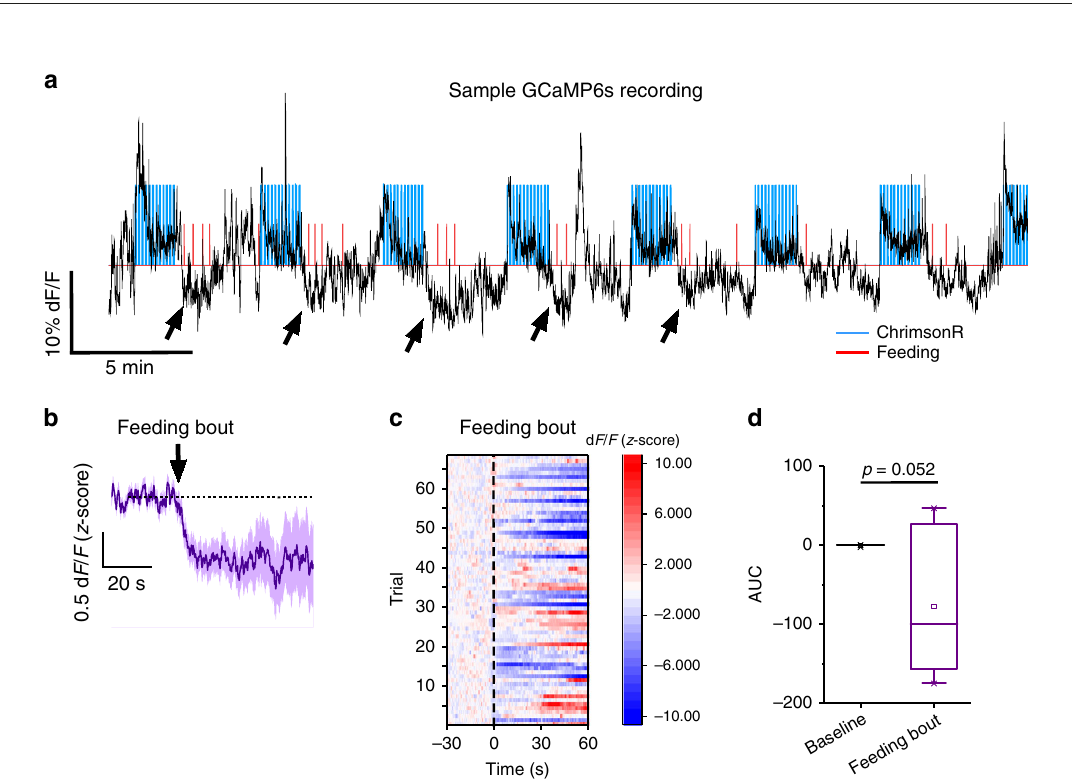
Fig. 4 The activity of pPVT – NAc neurons increases during food-seeking behavior in hungry mice and decreases during feeding. a Schematic of the viral vector strategy and optical fi ber placement used for selectively expressing GCaMP6s in NAc-projecting neurons of the pPVT. b Schematics of the reward foraging task. To initiate a trial, mice awaited in the trigger zone for an auditory cue (8 KHz, 1 s) which signaled reward availability. Mice then ran to the reward zone to retrieve a liquid food reward. c Heatmap of GCaMP6s responses from pPVT – NAc neurons during performance of individual trials of the foraging task. GCaMP6s responses were time-locked to cue onset and trials were sorted by latency to complete a trial. Yellow dots represent fi rst nose- poke into the food-port. d Average GCaMP6s responses from pPVT – NAc neurons during the foraging task. Gray bar indicates the delivery of auditory cue during trial initiation. Trial inclusion criteria was set to trials performed under 10 s noted by the red dotted line. e Quanti fi cation of the changes in GCaMP6s fl uorescence in pPVT – NAc neurons during the onset of trial performance in the foraging task. AUC, Baseline, − 0.05 ± 0.02; Approach, 17.58 ± 5.87; n = 5 mice, two-sided Paired t-test, * P = 0.04. f Heatmap of GCaMP6s responses from pPVT – NAc neurons during feeding bouts in the foraging task. GCaMP6s responses were time-locked to fi rst nose-poke into the food-port. g Average GCaMP6s responses from pPVT – NAc neurons during feeding bouts in the foraging task. Gray line signals fi rst nose-poke into the food-port. h Quanti fi cation of the changes in GCaMP6s fl uorescence in pPVT – NAc neurons during the onset of feeding in the foraging task. AUC, Baseline, 0.52 ± 0.31; Approach, − 18.08 ± 2.91; n = 4 mice, two-sided Paired t-test, ** P = 0.008. Box chart legend: box is de fi ned by 25th, 75th percentiles, whiskers are determined by 5th and 95th percentiles, and mean is depicted by the square symbol. Data presented as mean ± SEM.